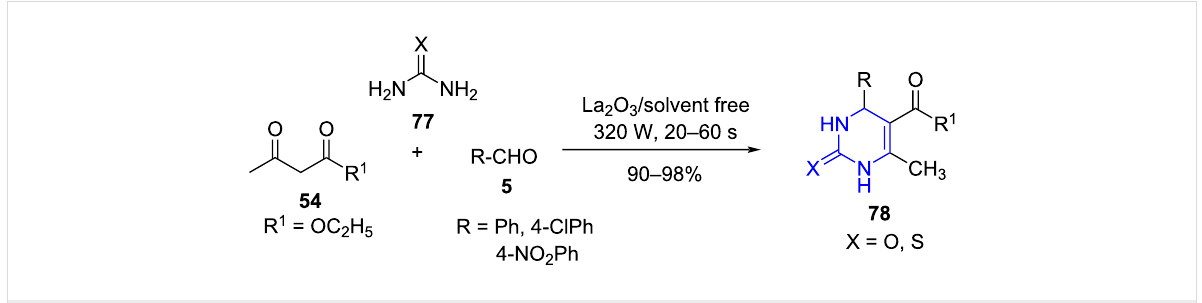
Scheme 27: Two proposed mechanisms for pyrimidinone synthesis.